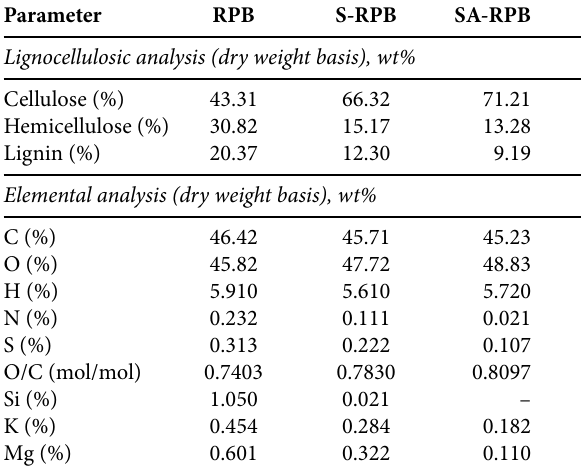
Table 1 . Chemical compositions of RPB, S-RPB, and SA-RPB Parameter